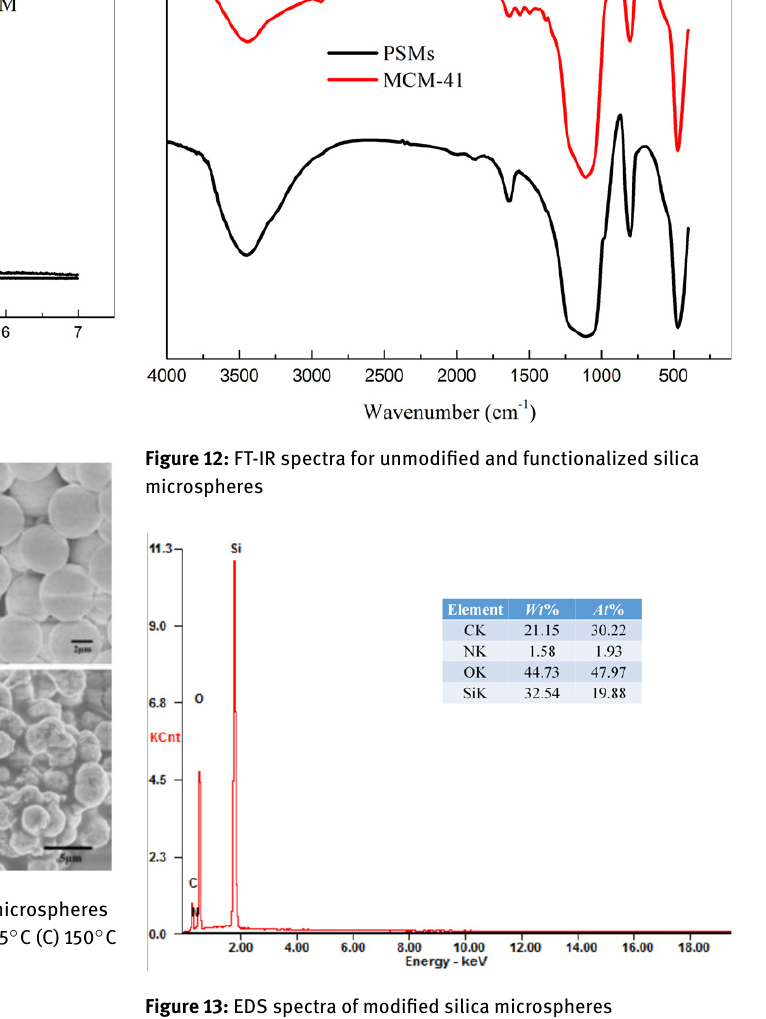
Figure 13: EDS spectra of modified silica